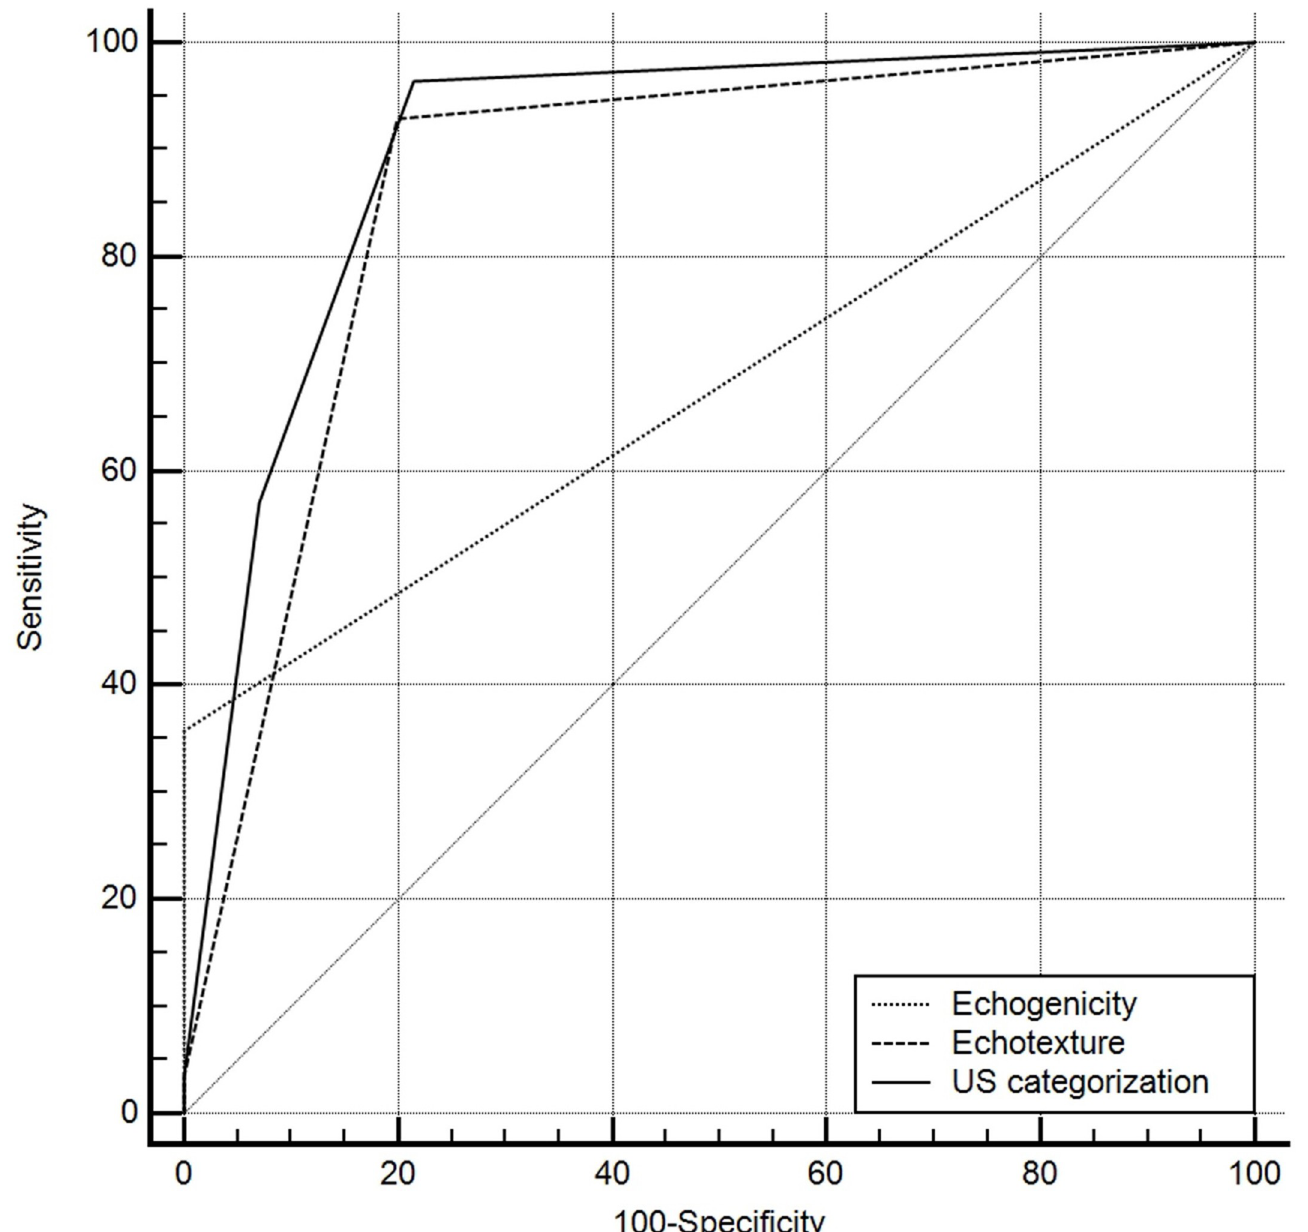
Fig 3. Comparison of diagnostic performance of each independent ultrasound (US) predictor for detecting diffuse parotid disease (DPD). For the US categorization, category 3 ( � 2 abnormal US features) was used as a cut-off value. The diagonal line represents 50% of the area under the receiver operating characteristic (ROC) curve and refers to a hypothetical marker that has no discriminatory power for differentiating DPD from normal parotid parenchyma.